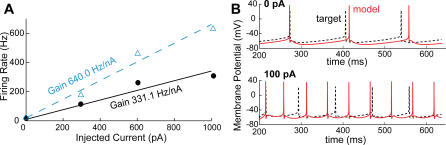
Quantifying Model Output(A) Computing firing rate gain. Black circles and solid line show firing rates and the associated fit for a model with a gain of 331.1 Hz/nA. A model with a gain of 640.0 Hz/nA is also shown (blue open triangles and dashed line).(B) Typical match of optimized model (red) against target data (black dashed line), for 0 and 100 pA injected current (top and bottom, respectively). Models were constrained to match the general AP shape, and approximate firing rates, of the synthetic target data.